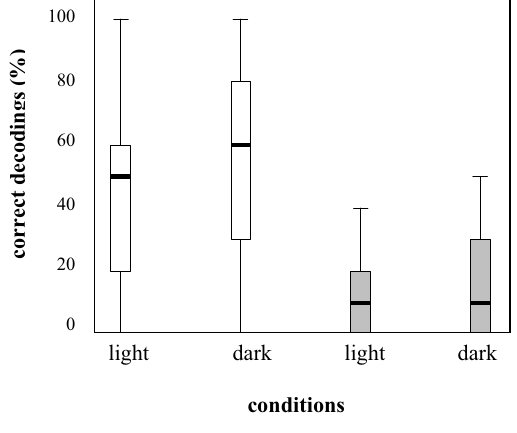
Fig. 6 – Percentage of correctly decoded stimuli (here: numbers) shown for the two experimental conditions: tests in normal light orinthedark. Leftboxplots: phonatednumbers. Rightboxplots: whisperednumbers. Stimuliwerepresentedthroughheadphones with an amplitude of about 25